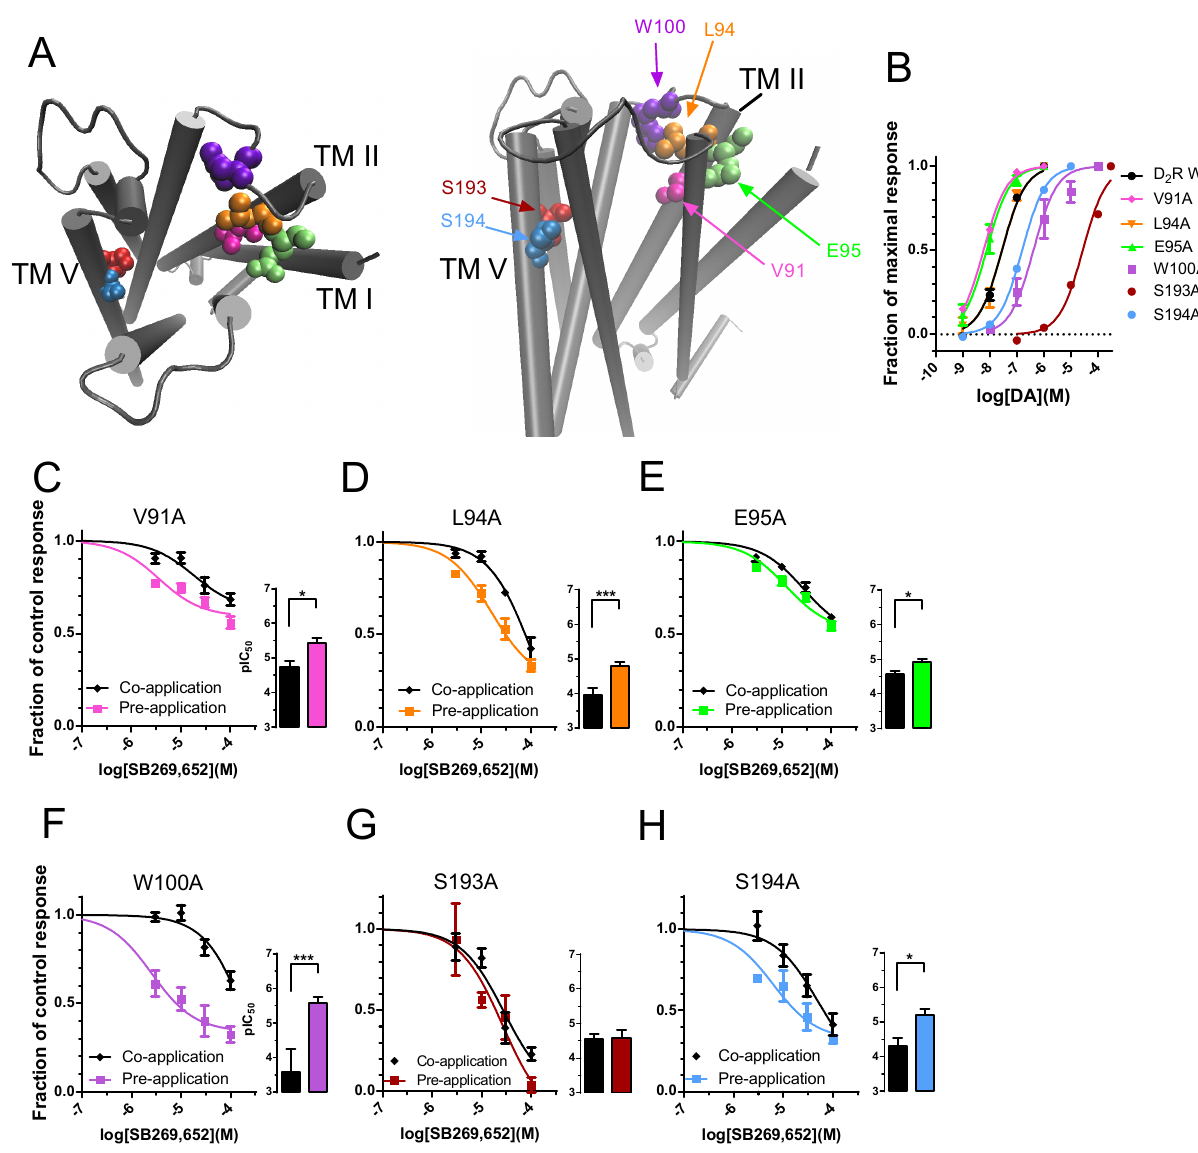
Figure 2. Mutation of critical residues in the D 2 R OBS and SBP reduce the effect of pre-application on SB269,652 potency. ( A ) Schematic representation of D 2 R structure showing the location of the mutated residues in the OBS and SBP. ( B ) DA potencies at the WT D 2 R and at the SBP and OBS mutants. Equation (1) was fit to the agonist data as described in the Methods section. See Table 1 for EC 50 values. ( C ) Concentration–response relationships for SB269,652 at the D 2 R V91A mutant, co-applied with 10 nM DA (black, n = 7–9) and pre-applied during 87 s (pink, n = 5). ( D ) Concentration–response relationships for SB269,652 at the D 2 R L94A mutant, co-applied with 10 nM DA (black, n = 5–7) and pre-applied during 87 s (orange, n = 5). ( E ) Concentration–response relationships for SB269,652 at the D 2 R E95A mutant, co-applied with 10 nM DA (black, n = 9–10) and pre-applied during 87 s (green, n = 6). ( F ) Concentration–response relationships for SB269,652 at the D 2 R W100A mutant, co-applied with 100 nM DA (black, n = 5–7) and pre-applied during 87 s (purple, n = 6). ( G ) Concentration– response relationships for SB269,652 at the D 2 R S193A mutant, co-applied with 10 µ M DA (black, n = 6) and pre-applied during 87 s (dark red, n = 3). ( H ) Concentration–response relationships for SB269,652 at the D 2 R S194A mutant, co-applied with 100 nM DA (black, n = 4–5) and pre-applied during 87 s (blue, n = 3). Equation (2) was fit to the inhibition data as described in the Methods section. See Table 2 for pIC 50 values. Data are displayed as mean ± SEM. Asterisks indicate statistical significance: *, p < 0.05; ***, p < 0.001,